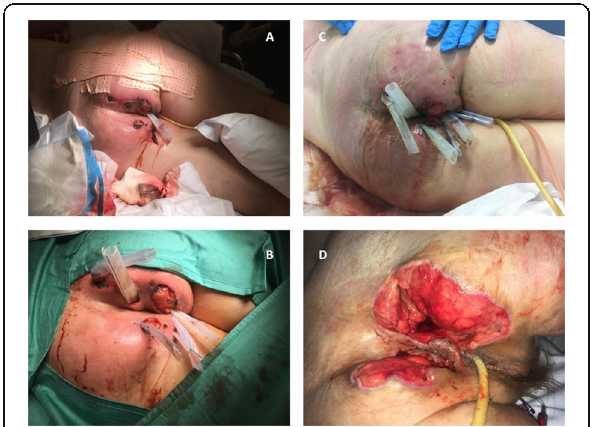
Fig. 2 (abstract A104). A ) Perianal and perineal ulcerations on day fivel before surgical toilette; B ) Operation and easy-flow drain